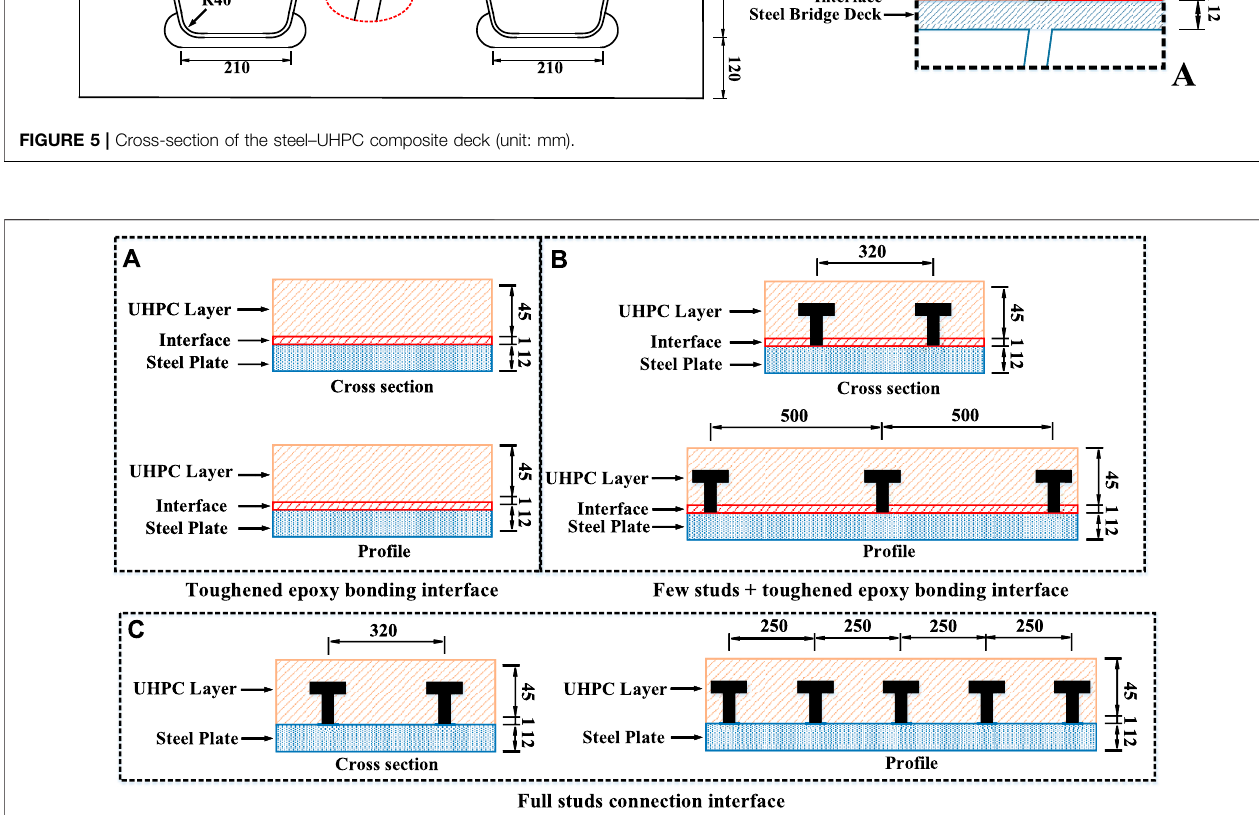
FIGURE 6 | Interface design of the steel – UHPC composite deck (unit: